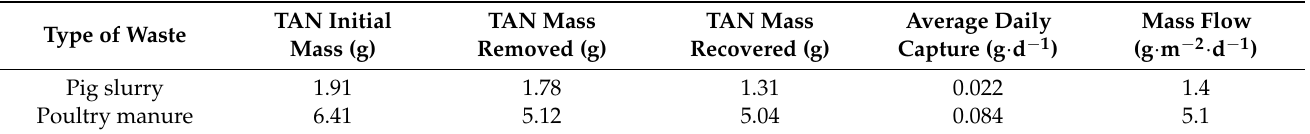
Table 3. Mass balance of nitrogen (measured as TAN) recovered at laboratory scale using slurry and poultry manure. Type of Waste